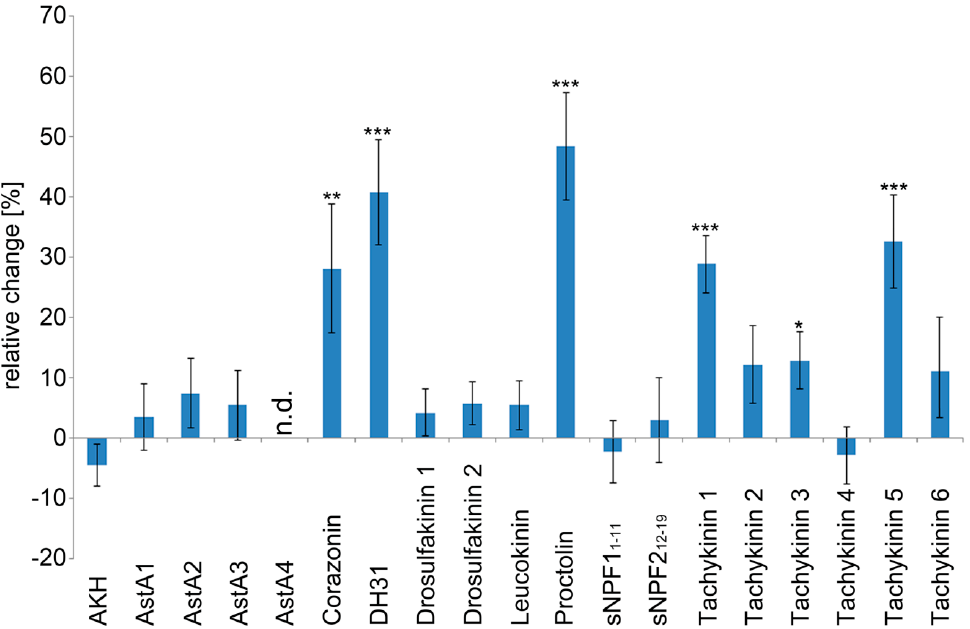
Figure 1. Heart rate is modulated by peptide signalling in semi-intact Drosophila larvae. Individual effects of the tested peptides (1 × 10 − 7 M) on heart rate. Data are presented as mean values (± S.E.M.) of the relative changes in heart rate in relation to the individual control preparations (prior to peptide application). A minimum of ten animals per peptide were measured. Significance levels are